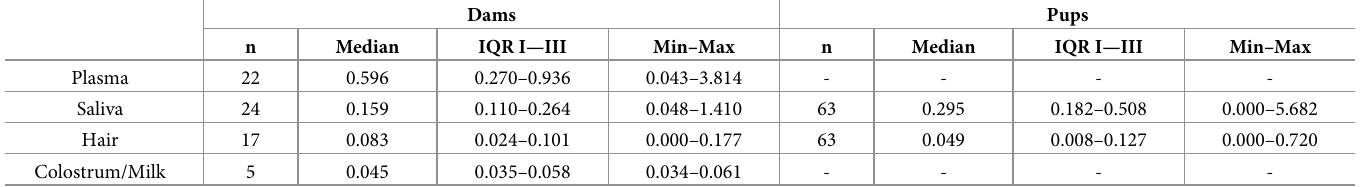
Cortisol values obtained in saliva and hair of pups are reported in Table 3 as well. Cortisol con- centration significantly differed between the two matrices in the entire caseload, with saliva cortisol always higher than in hair ( P < 0.0001). The independent variable of the first Table 3. Median, I-III interquartile ranges, minimum and maximum values of cortisol concentration ( μ g/dL) in dams and pups in different matrices on the entire caseload. Dams